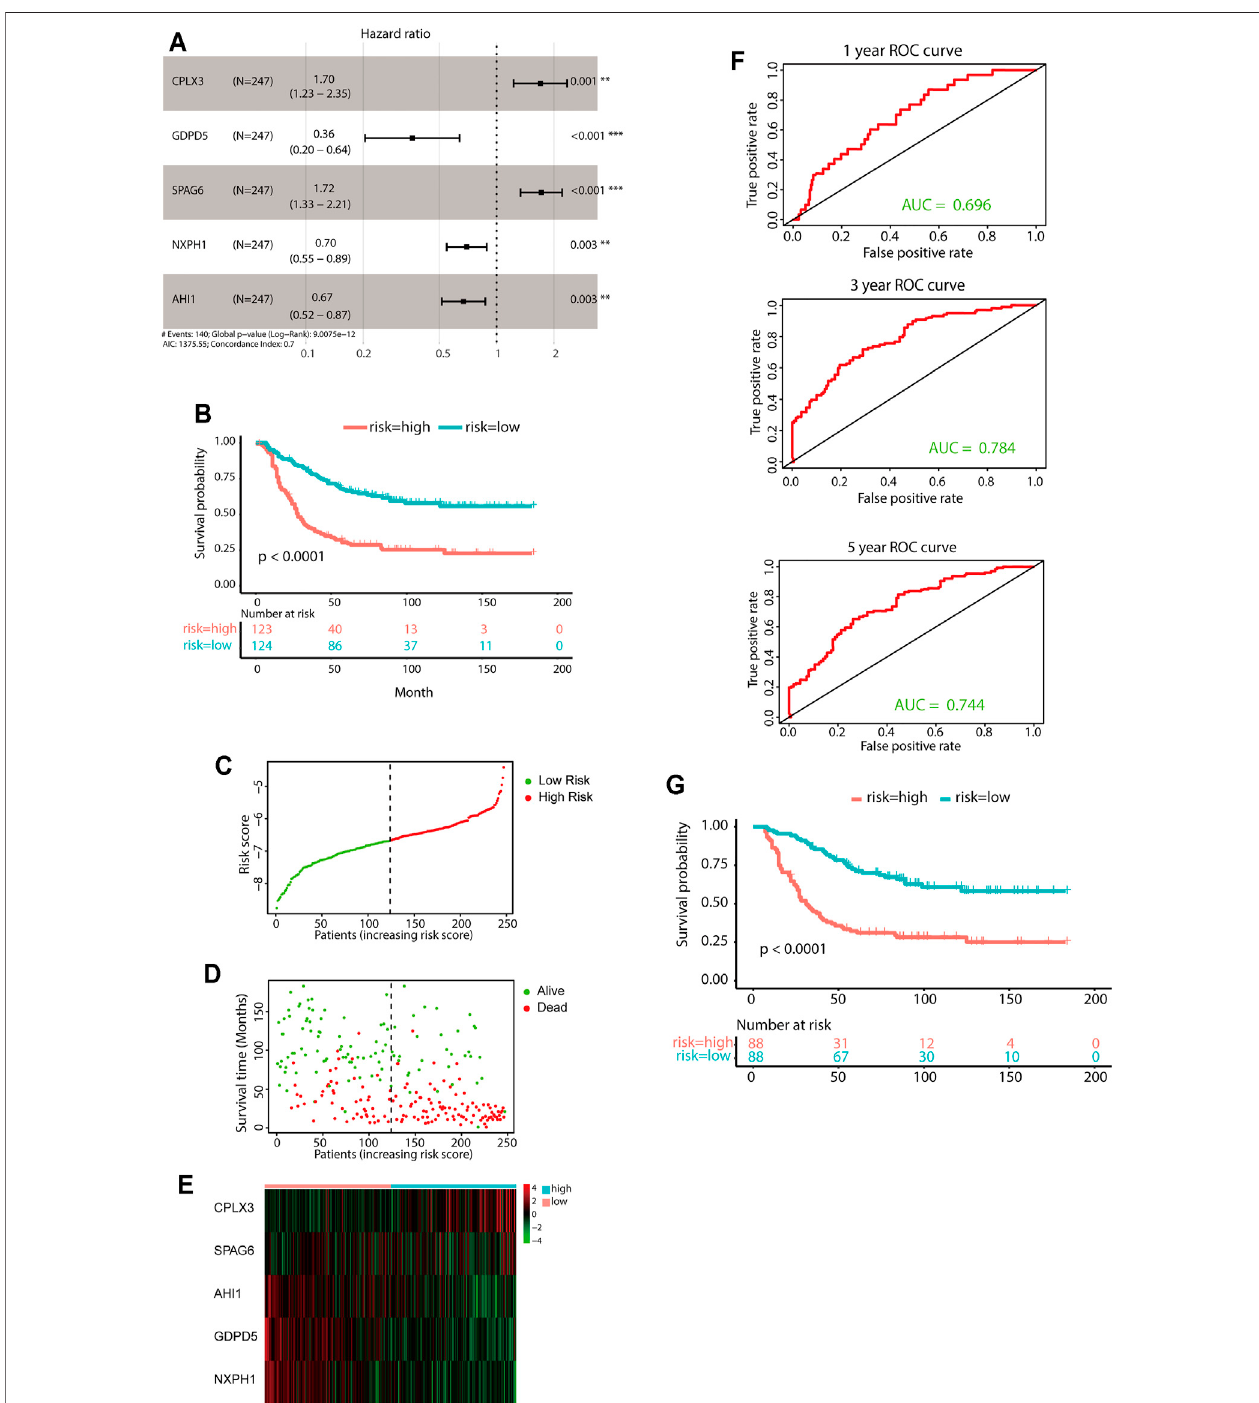
FIGURE 4 | Construction of the predictive fi ve-gene signature. (A) Prognostic effect of the fi ve-gene signature derived from stepwise Cox regression survival analysisforoverallsurvivalintheTARGETdataset.** p < 0.01,*** p < 0.001. (B) KMcurvesforoverallsurvivalofthetworiskgroupsderivedfromthe fi ve-genesignaturein the TARGET data set. The p -value wascalculated by the log-rank test. (C-E) Distribution ofthe riskscore (C) , the associated survival data (D) , and the fi ve-gene mRNA expression (E) intheTARGET dataset. (F) ROCcurves for1-year, 3-year,and 5-yearoverallsurvivalpredictionsforthe fi ve-genesignature. (G) KM survivalcurves of the fi ve-gene signature in the MYCN nonampli fi cation